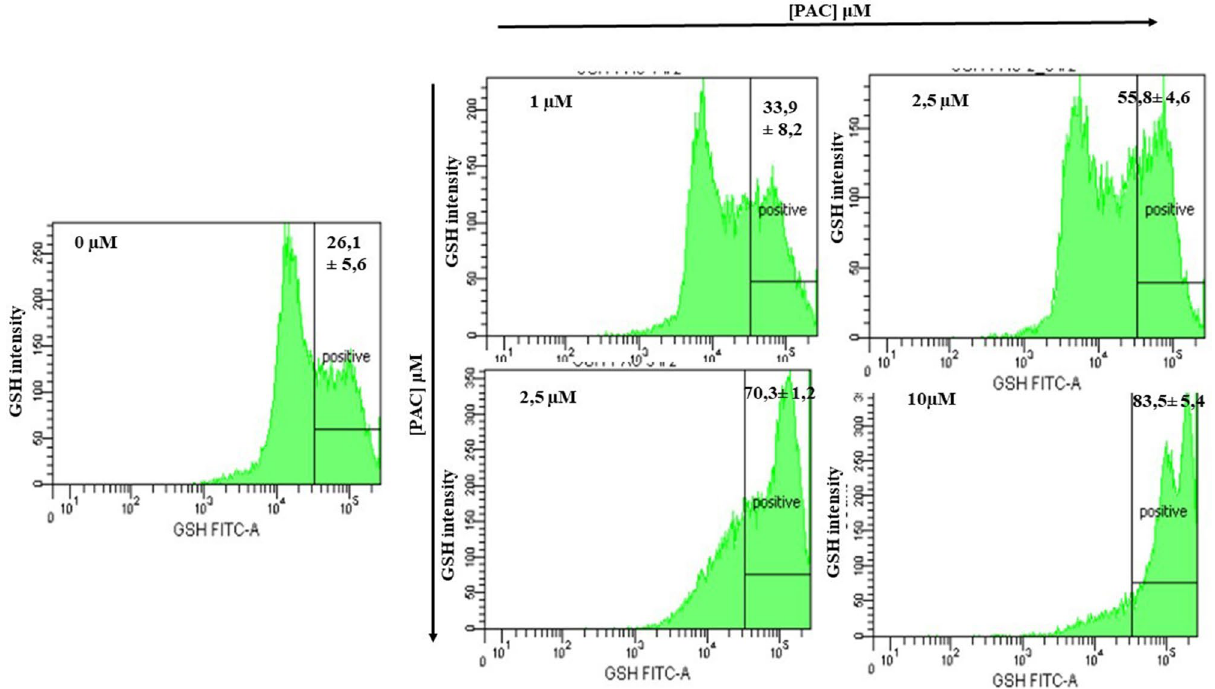
Figure 8. PAC acts as a powerful antioxidant by producing intracellular glutathione (GSH). To evaluate the levels of intracellular GSH, fluorescence intensity was determined by Flow Cytometry assay and the percentage of GSH-positive cells was calculated (n = 3).